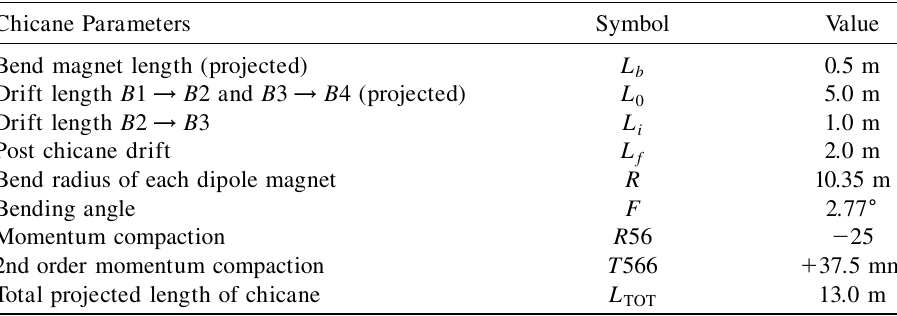
TABLE III. List of the four bends test chicane